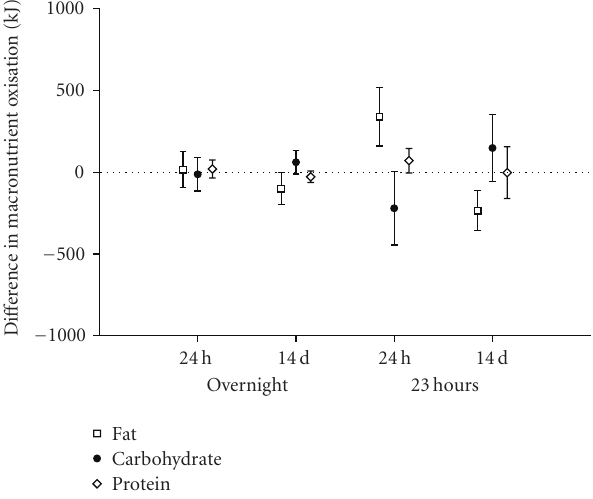
Figure 2: Mean di ff erences and standard deviations of di ff erences between measures of fat, carbohydrate, and protein oxidation, made overnight and over 23 hours, and repeated after a 24-hour or 14-day interval. Untreated (placebo) subjects, n =